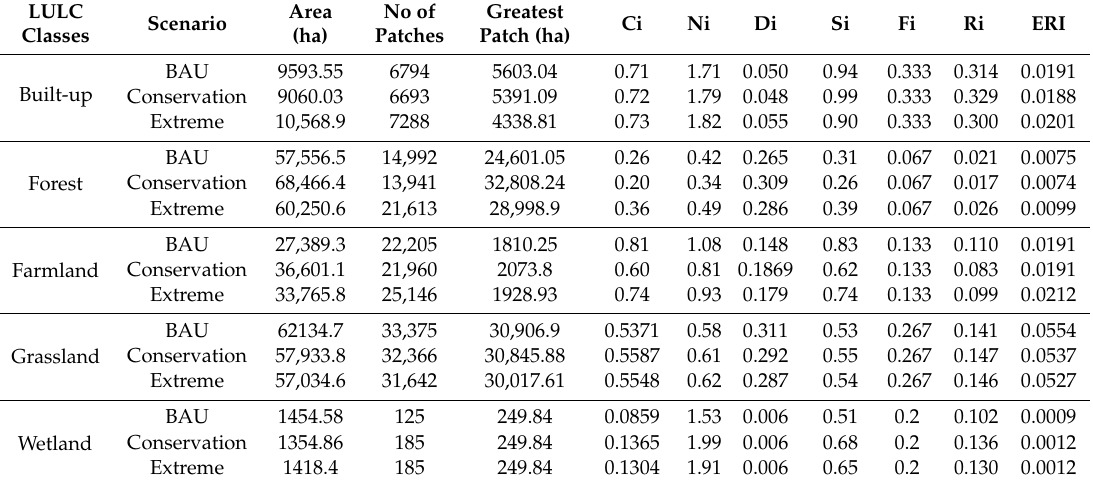
Table 11. Ecological risk indices for the 2027 scenarios (Ci: fragmentation index; Ni: isolation index); Di: dominance index; Si: disturbance degree index; Fi: ecological fragility index; Ri: loss index; ERI: ecological risk index).